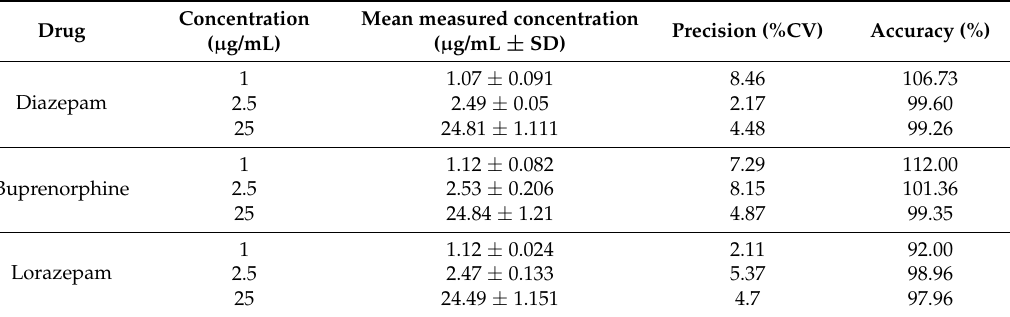
Table 3. Inter-day accuracy and precision of HPLC